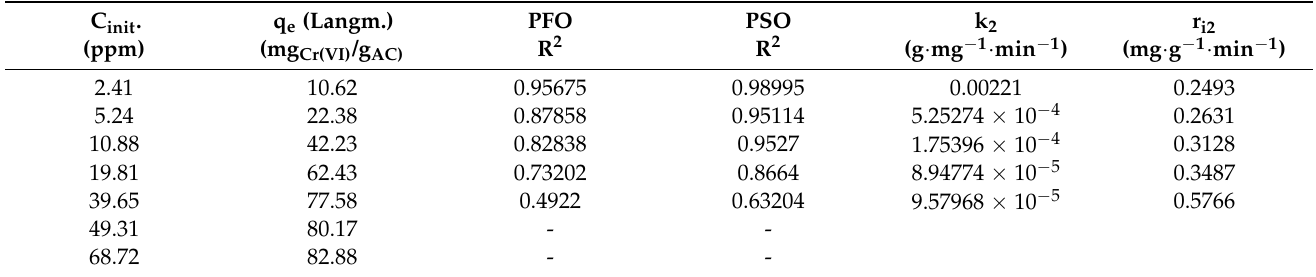
Table 5. Total Cr(VI) amount uptake to the mAC-snack adsorbent at equilibrium stage for different initial concentrations.